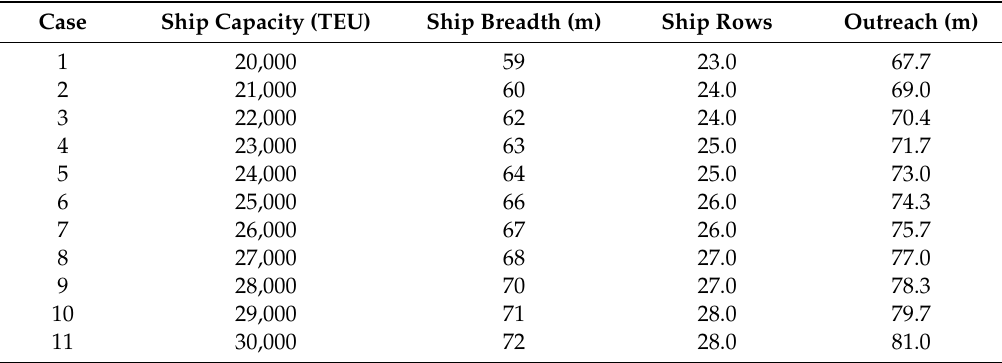
Table 12. Prediction of QC Outreach by Ship Capacity